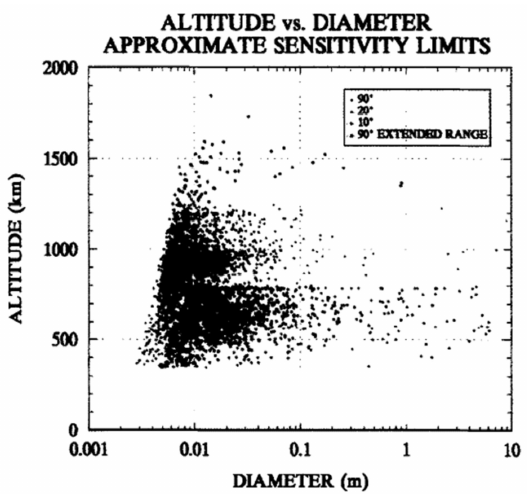
Figure 5. Altitude vs. diameter at different elevation angles for 1990–94 Haystack radar mea- surements [16]. Reprinted from Advances in Space Research, Copyright 1995, with permission from Elsevier.